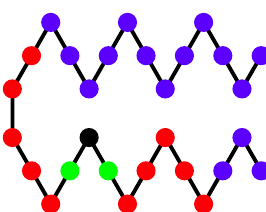
Figure 4. Sketch of a representative polymer structure detailing types of monomer-monomer interactions considered in this paper. The black monomer interacts via the finitely extensible nonlinear elastic (FENE) potential [34,44,45] with monomers to which it is bonded (green). Nonbonded monomers interact according to the Lennard-Jones potential. The LJ interaction between the black monomer with monomers separated by six or fewer bonds (red) contributes to q 1 while interaction with monomers separated by more than six bonds (blue) contributes to q 2